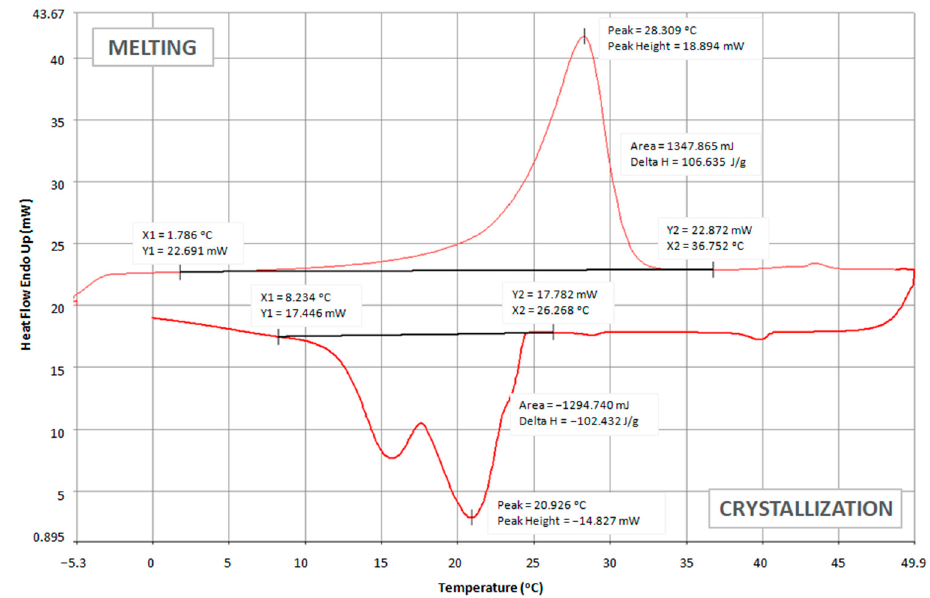
Figure 8. DCS thermogram of PES + PCM2_30 insert. Table 4. Results of DSC analysis of PCM microcapsules and nonwoven inserts.